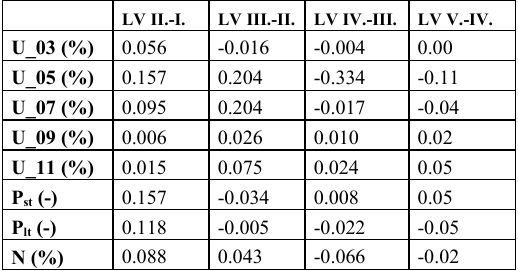
T RENDS OF CHANGES IN THE SELECTED VOLTAGE QUALITY PARAMETERS IN THE LV NETWORKS LV II.-I.